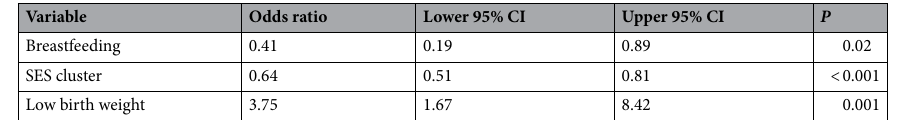
Table 2. Multivariate logistic regression for a feeding disorder. CI confidence interval, SES socioeconomic Status.